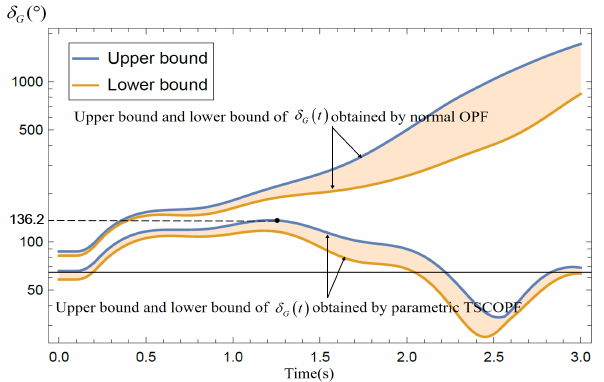
Figure 11. The lower bound and upper bound trajecories of δ G104 obtained by the SCM and